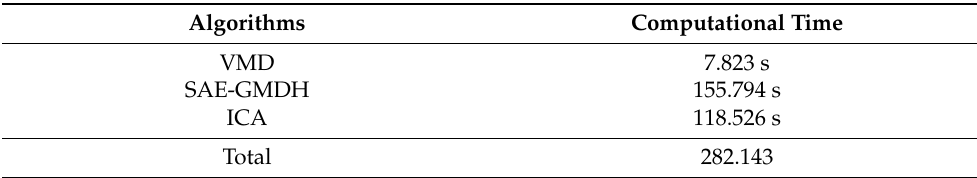
Table 8. The main computational time of the proposed